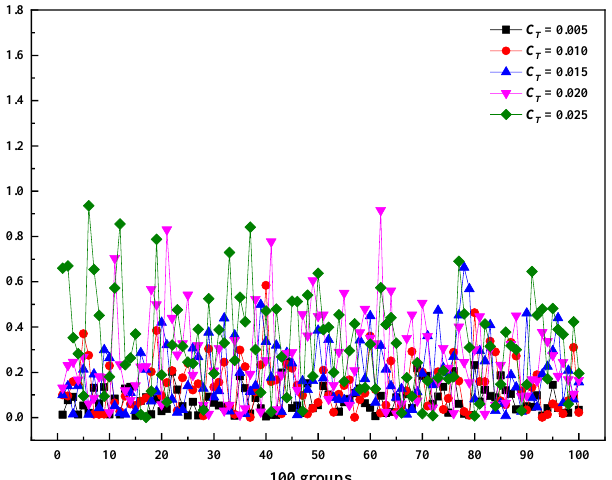
Figure 6. Center concentration deviation under different relative standard deviations of temperature at mean temperature 553 K.